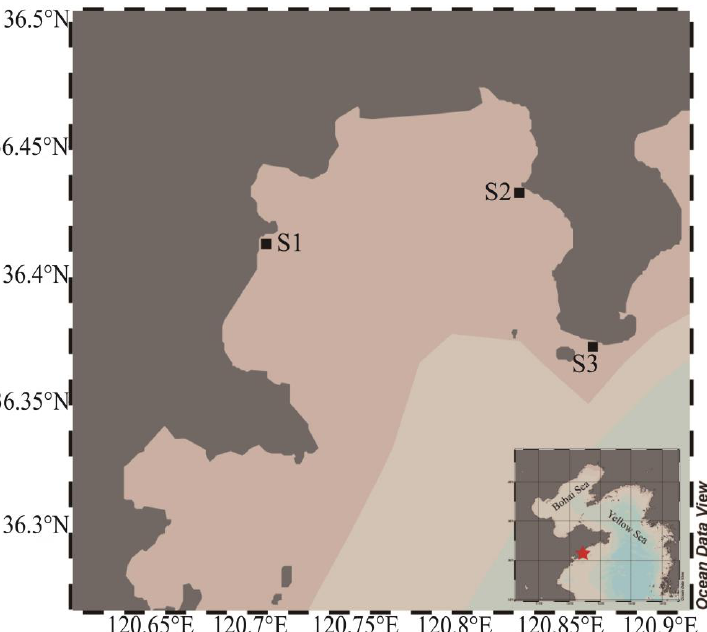
Figure 1. Map of the sampling location in Aoshan Bay, Qingdao. Black square indicates the sampling stations. Figure was generated using Ocean Date View (v 5.5.2) [24] .